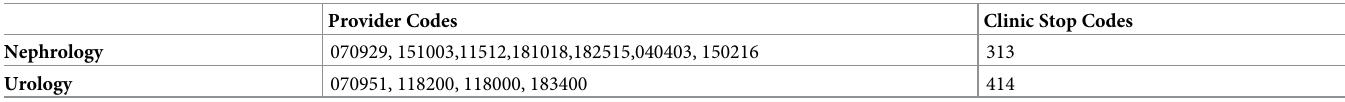
Table 1. Nephrology and urology clinic visit codes.